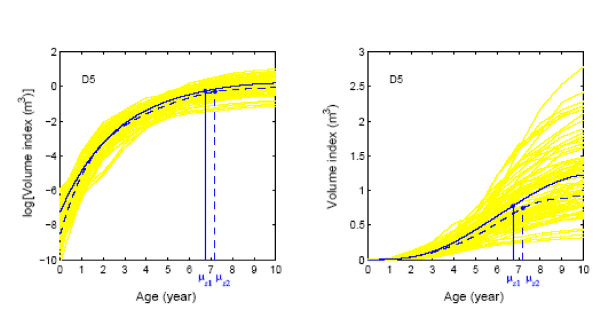
Volume growth curves for two different QTL genotypes for the QTL detected on linkage group 5 by the Legendre polynomial-based model. See Figure 3 for all the explanations.